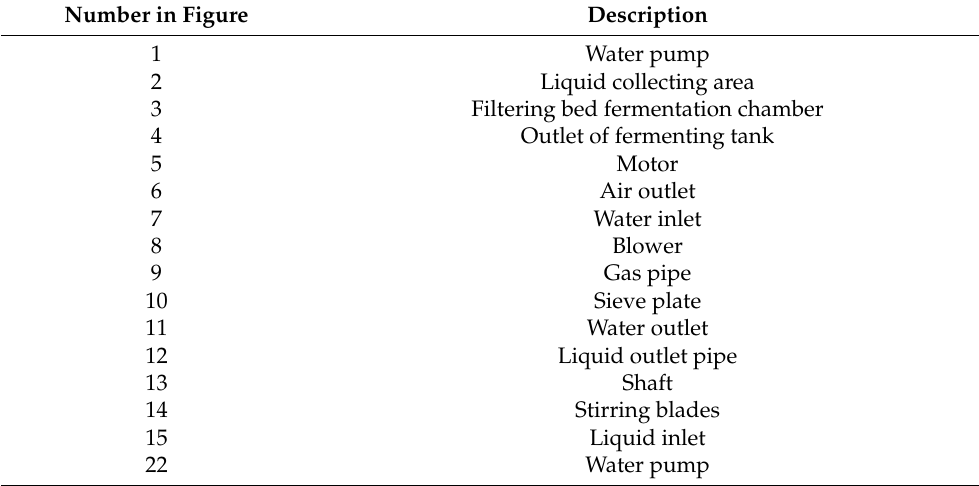
Table A3. An anaerobic manual composter from CN1206189C [90].